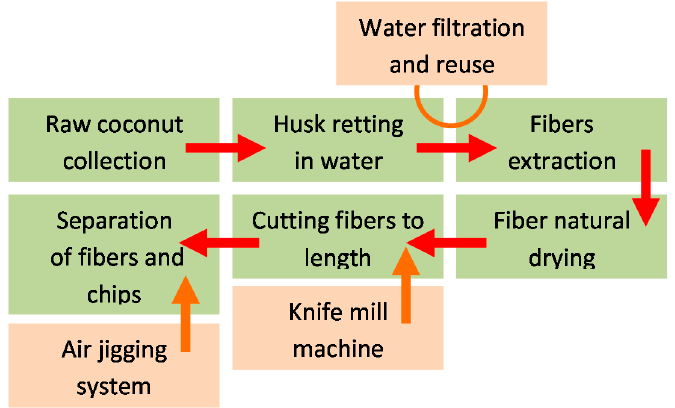
Figure 14. Eco-friendly method of coconut fibers preparation.